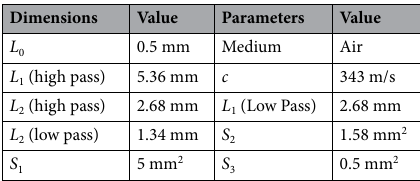
Table 1. Geometrical and material parameters.